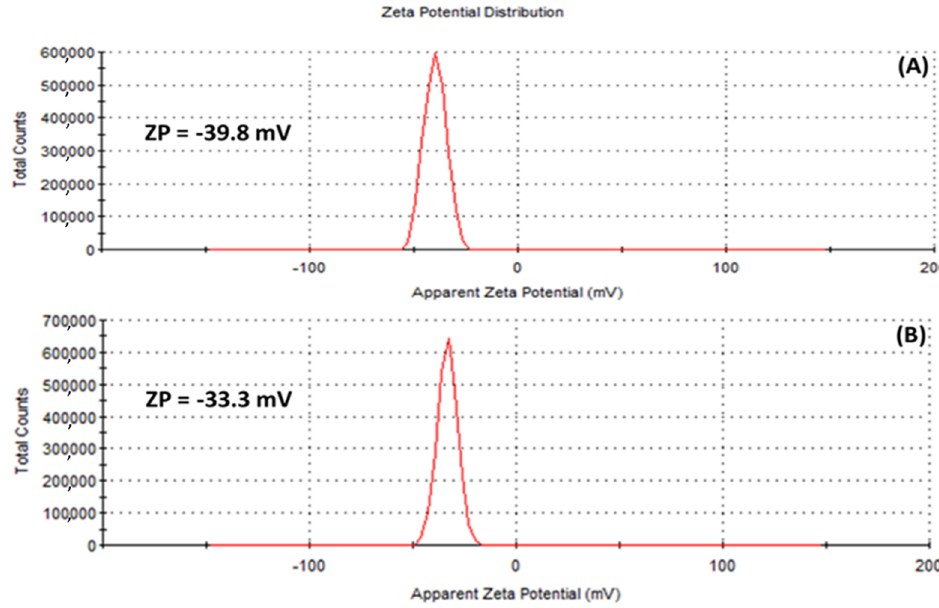
Figure 6. Zeta potential of ( A ) HE-AgNPs and ( B ) HP-AgNPs indicating that the surfaces of the nanoparticles are surrounded by negative ions.